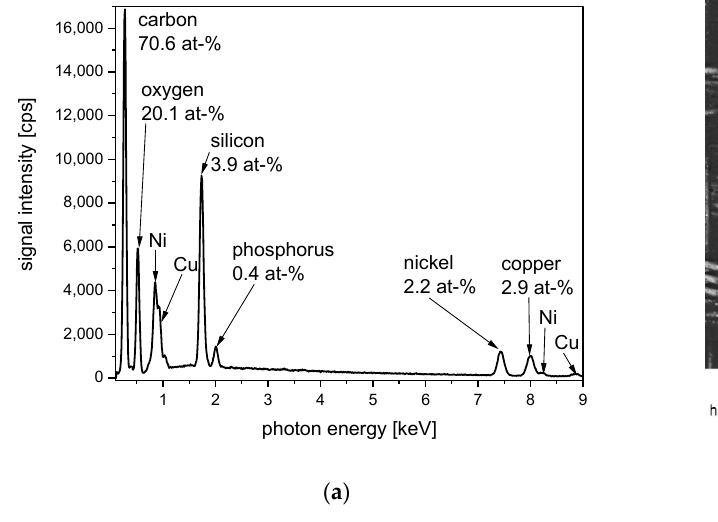
Figure 40. Presentation of a commercially available fabric containing steel fibers offered for the shielding of radio waves (electrosmog) (product from YShield, type Steel-Twin): ( a ) EDS spectrum of this fabric with detected chemical elements and their determined concentration; ( b ) SEM image.